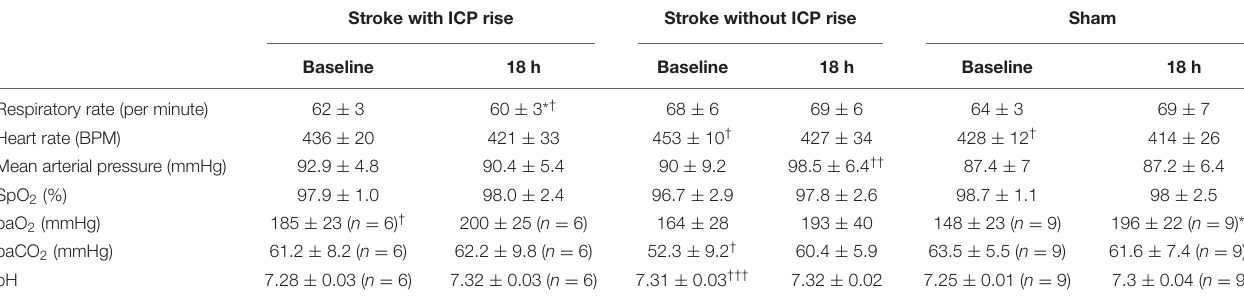
TABLE 1 | Comparison of physiological parameters between baseline and 18 h post-stroke within each group, paired t